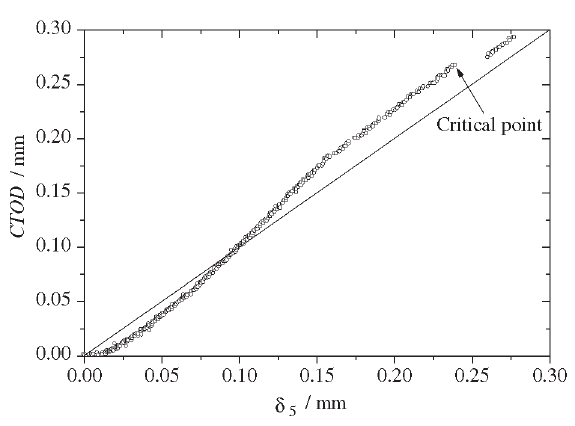
Figure 7. CTOD vs. δ